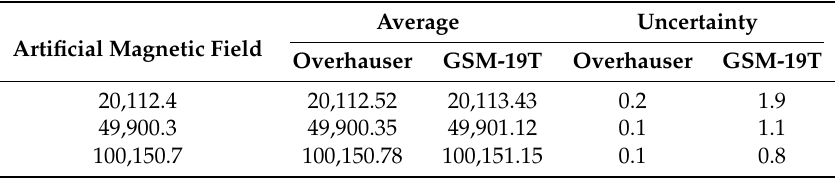
Table 1. Results of range and uncertainty (unit: